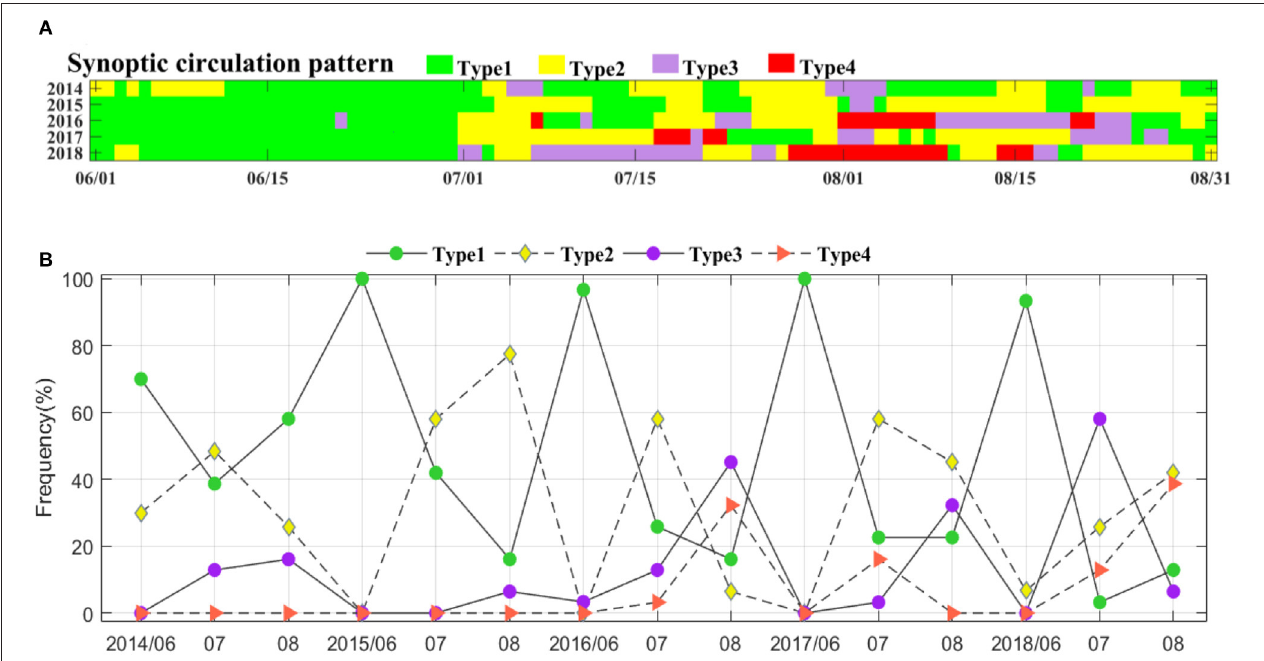
FIGURE 3 | (A) Time distribution series of the four weather patterns (B) Month-by-month frequency of each weather pattern.